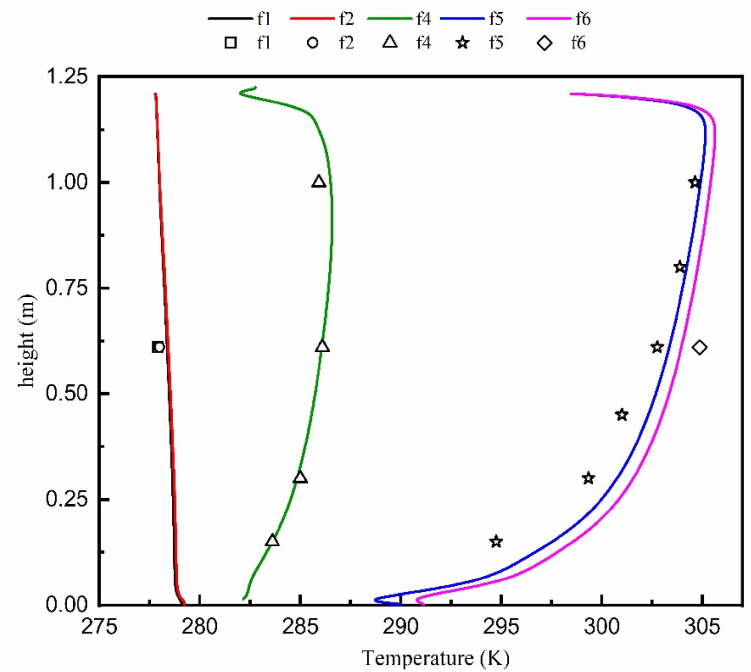
Figure 17. Experimental and numerical temperature profiles for the three glazings, according to k-w models, P = 320 W.m − 2 .